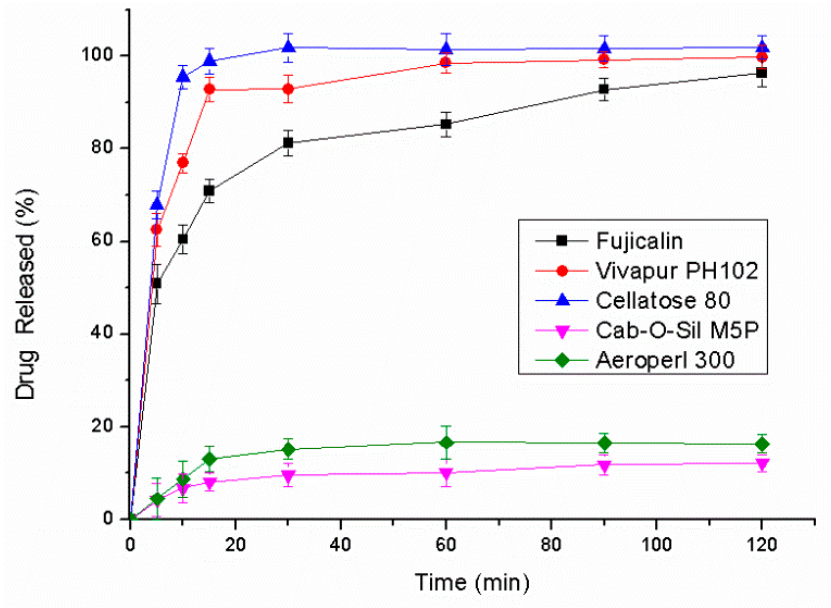
Figure 9. Dissolution profiles of mixtures of the liquid SNEDDS and various solid adsorbents ( n = 3).